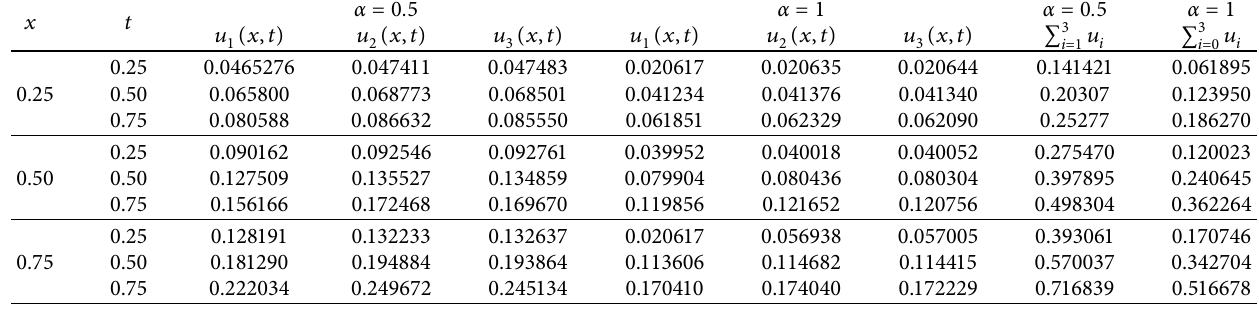
� q � 0 . 5 , 1 and α � β � 0 . 5 for Example 1 2